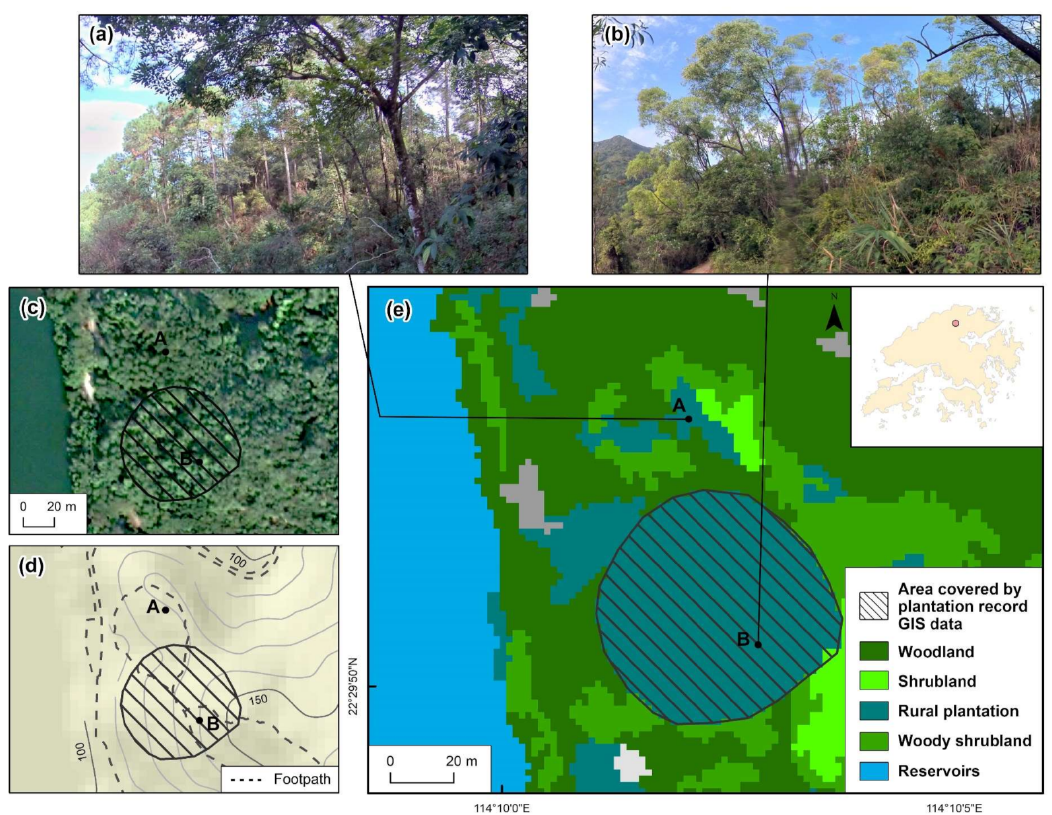
Figure 12. Selected sites of rural plantation identified by RF classification model (Point A) and plantation record GIS data (Point B) respectively; ( a ) photo of point A taken in the field, which is a plantation of Pinus massoniana ; ( b ) photo of point B taken in the field, which is a plantation of Acacia auriculiformis ; ( c ) true-colour composite of the WorldView image; ( d ) topographic map; ( e ) habitat map produced in this